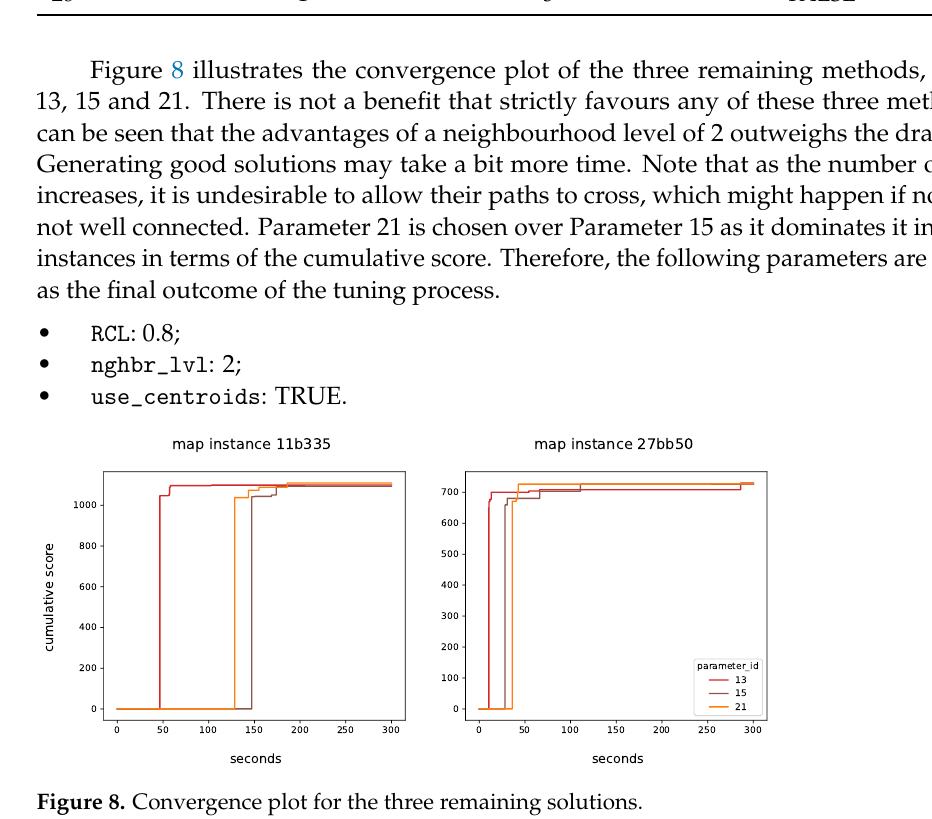
Figure 8. Convergence plot for the three remaining